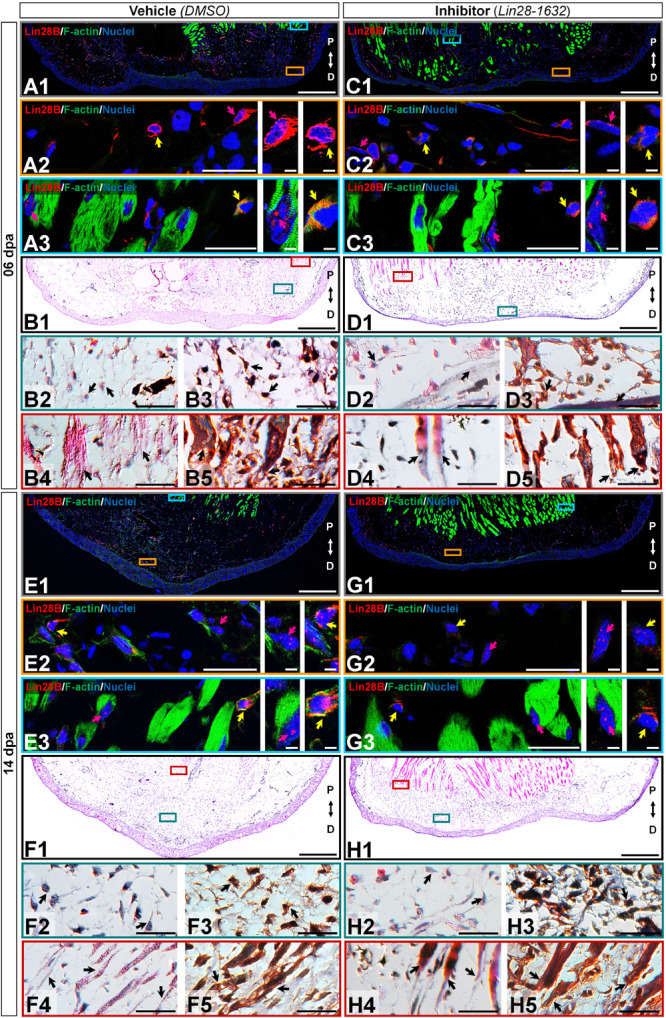
Histological changes after functional inhibition of Lin28 in key regeneration stages. (C,D,G,H) Histological sections of limbs treated with Lin28-1632 inhibitor, oriented in the Proximal-Distal axis. (A,B,E,F) Histological sections of limbs treated with vehicle, oriented in the Proximal-Distal axis. (A–D) Apical epidermal cap stage (06 dpa). (E–H) Early blastema stage (14 dpa). (A1,C1,E1,G1) Subcellular localization of amxLin28B marked in red, by contrast with DAPI (blue) and Phalloidin (green). Scale bars: 500 μm. (A2-3,C2-3,E2-3,G2-3) Magnifications with different color contours to remark some areas of interest for amxLin28B in red, DAPI in blue, and Phalloidin in green; arrows in yellow and magenta have in turn their own zoom in. Scale bars: 50 and 5 μm, respectively. (B1,D1,F1,H1) General tissue morphology shown with Hematoxylin & Eosin staining. Scale bars: 500 μm. (B2/4,D2/4,F2/4,H2/4) Magnifications with distinct color contours to indicate some areas of interest in Hematoxylin and Eosin staining. Scale bars: 50 μm. (B3/5,D3/5,F3/5,H3/5) Differential staining to view changes on stroma for similar zones indicated in H&E ampliations. Scale bars: 50 μm. The distinct arrows point to diverse tissue components, as described in the results.